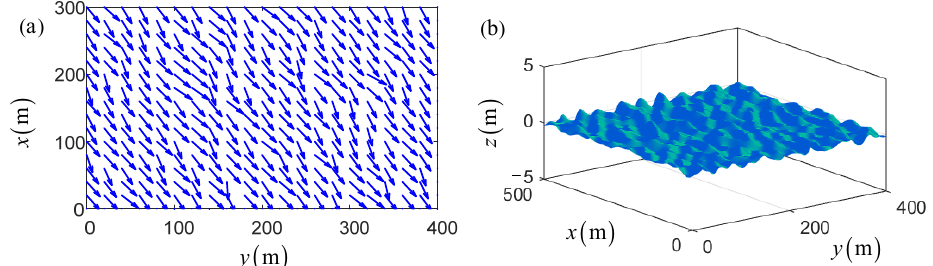
Figure 3. The simulated marine environment: ( a ) the 2-D sketch field of surface wind; ( b ) the 3-D irregular waves.